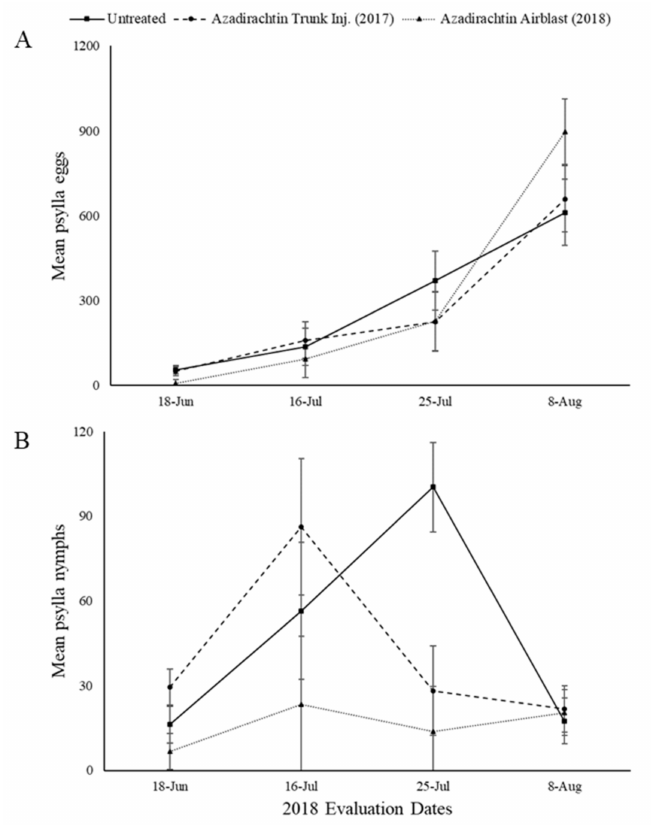
Figure 3. Mean number of pear psylla eggs ( A ) and nymphs ( B ) per 50 leaves in 2018 evaluations for the untreated and azadirachtin treatments. There was no significant di ff erence found between any of the treatments ( p ≤